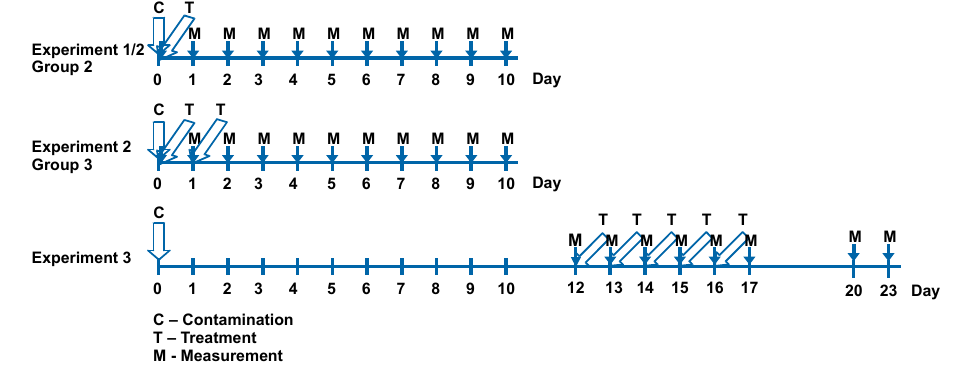
Figure 1. Schematic representation of the experimental methods.